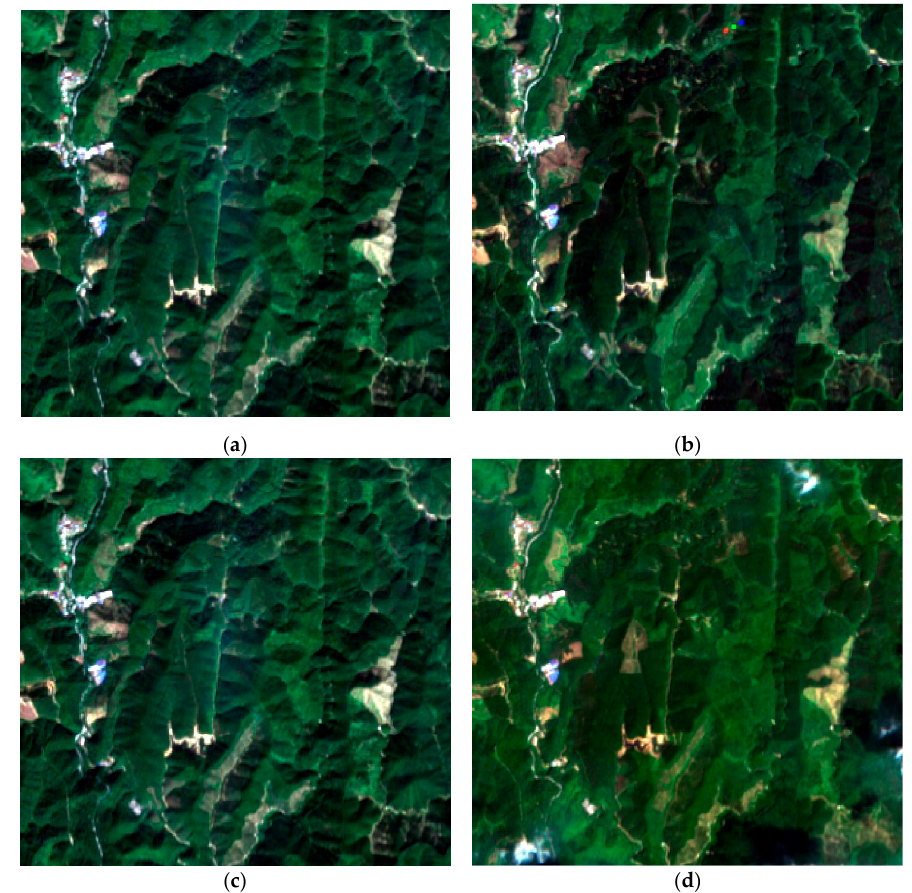
Figure 1. The study site in Gaofeng forest farm, Nanning, Guangxi Zhuang Autonomous Region, China.